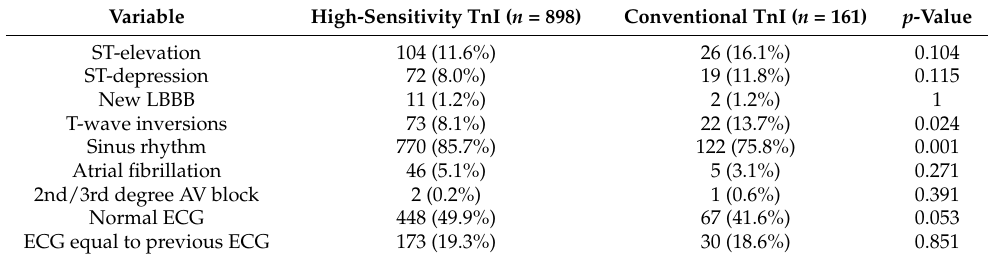
Table 3. Electrocardiogram (ECG) findings of study population 1